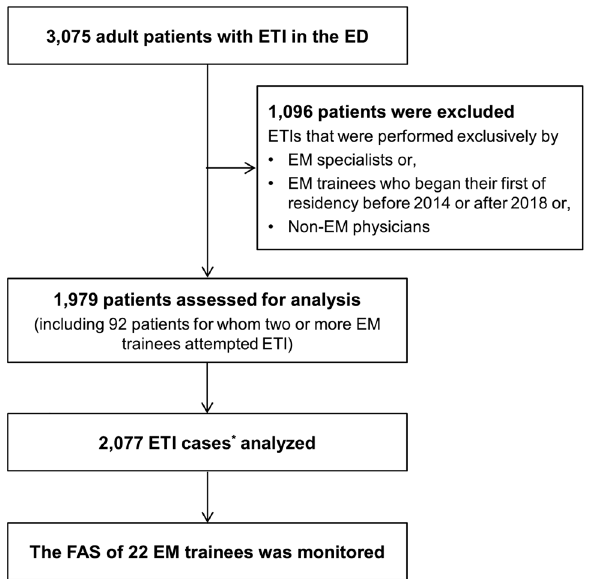
Figure 1. Study flowchart. ETI endotracheal intubation, ED emergency department, EM emergency medicine, FAS , first attempt success. *An ETI case was defined as an ETI attempt by an individual trainee on a